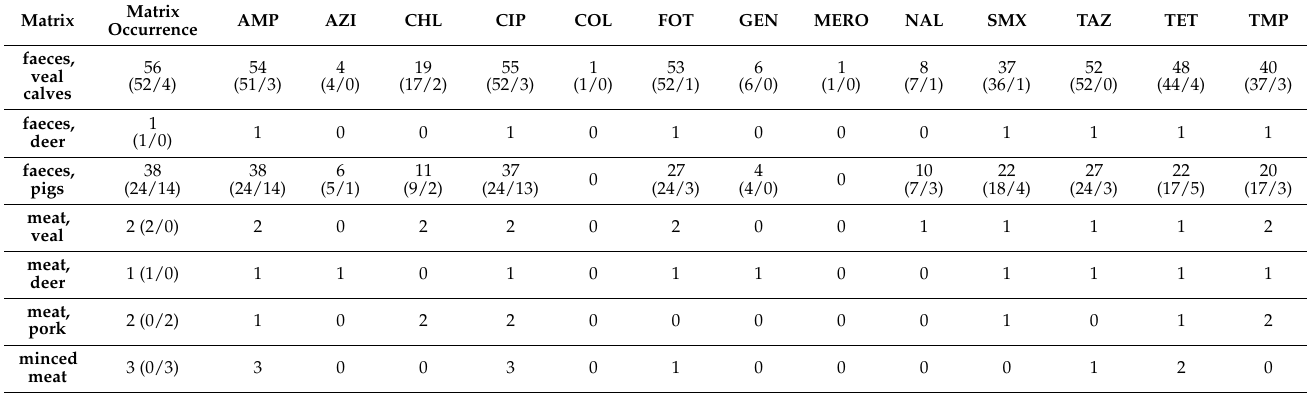
AMP—Ampicillin, AZI—Azithromycin, CHL—Chloramphenicol, CIP—Ciprofloxacin, COL—Colistin, FOT—Cefotaxime, GEN— Gentamicin, MERO—Meropenem, NAL—Nalidixic acid, SMX—Sulfamethoxazole, TAZ—Ceftazidime, TET—Tetracycline,